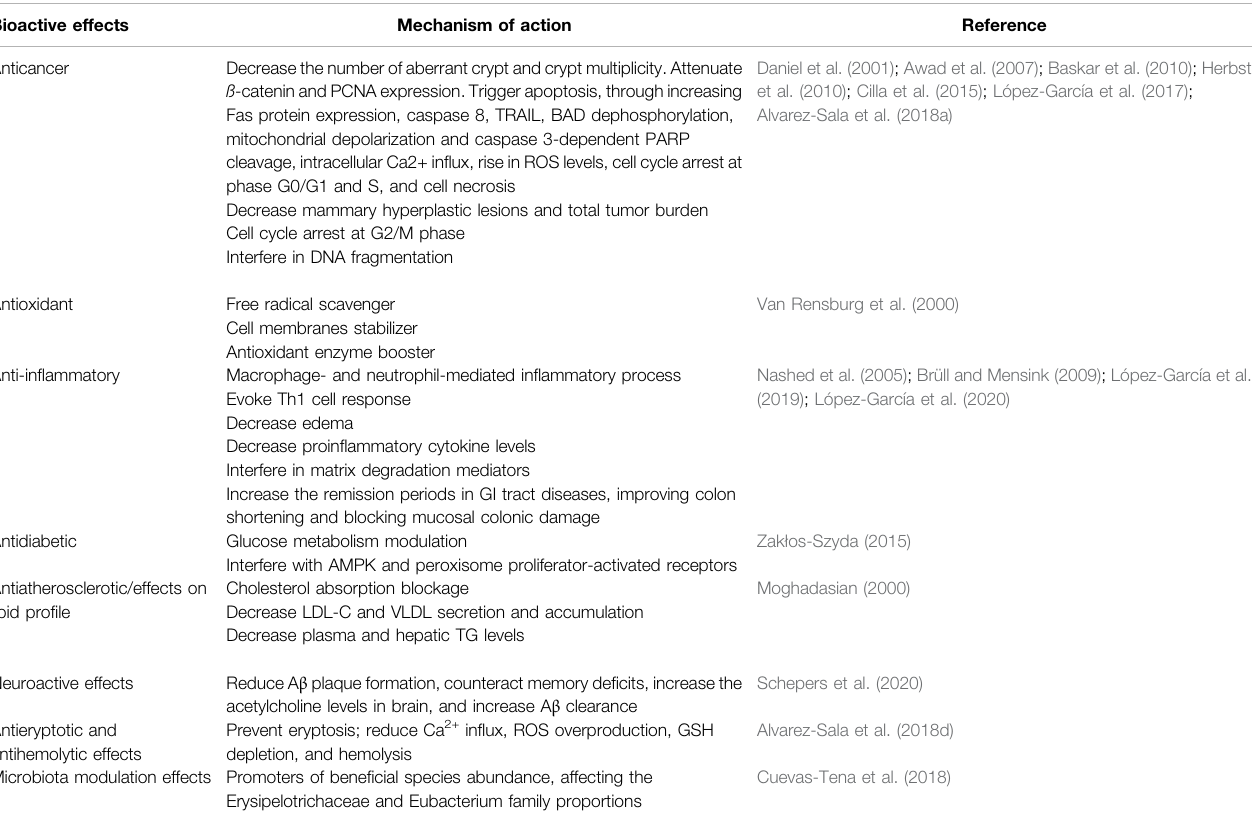
TABLE 1 | Preclinical phytosterol (PS) bioactive effects and the respective mechanisms of